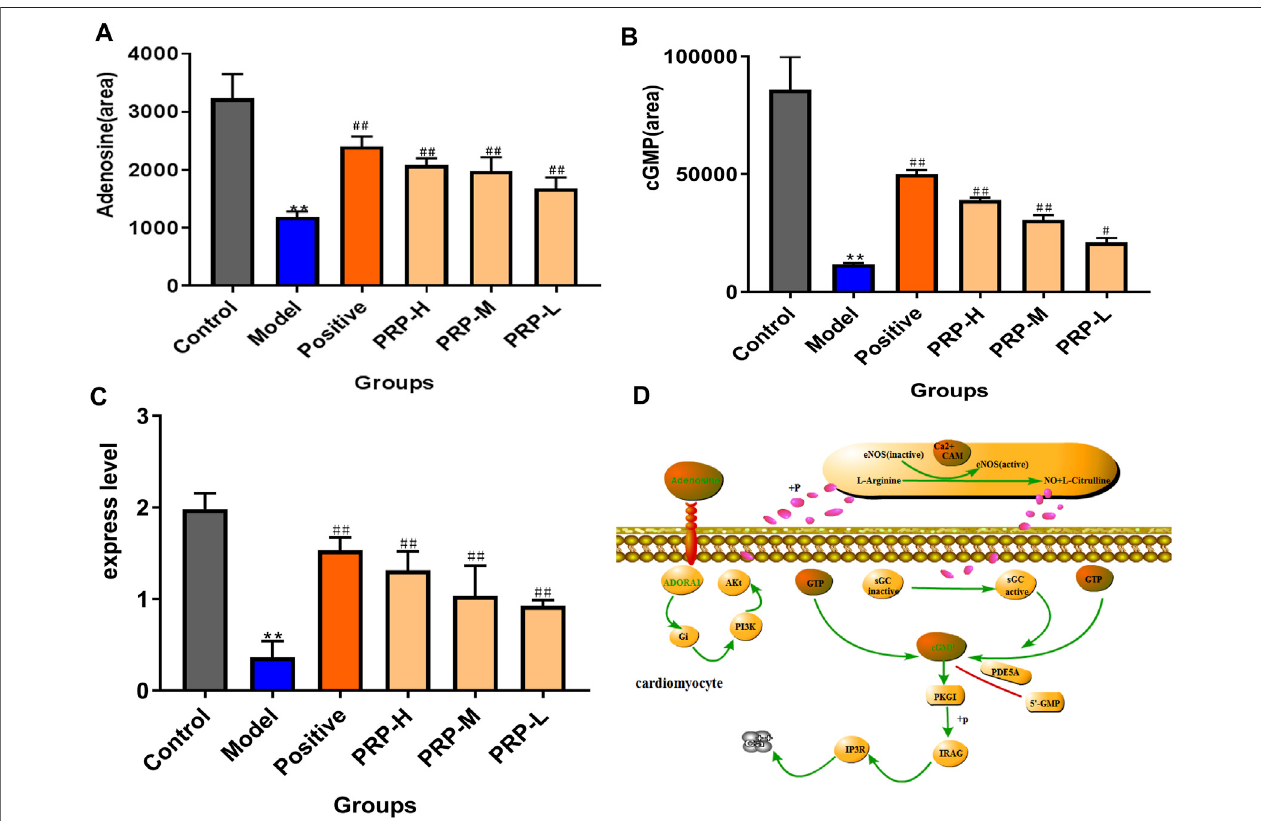
FIGURE5| PRP-mediated regulationofthelevelsofadenosineand cGMPmetabolitesandtheexpressionlevelofADORA1inthecGMP-PKGsignallingpathway. (A) Quantitative evaluation of adenosine metabolism; (B) quantitative evaluation of cGMP metabolic levels; (C) expression levels of ADORA1 in zebra fi sh determined